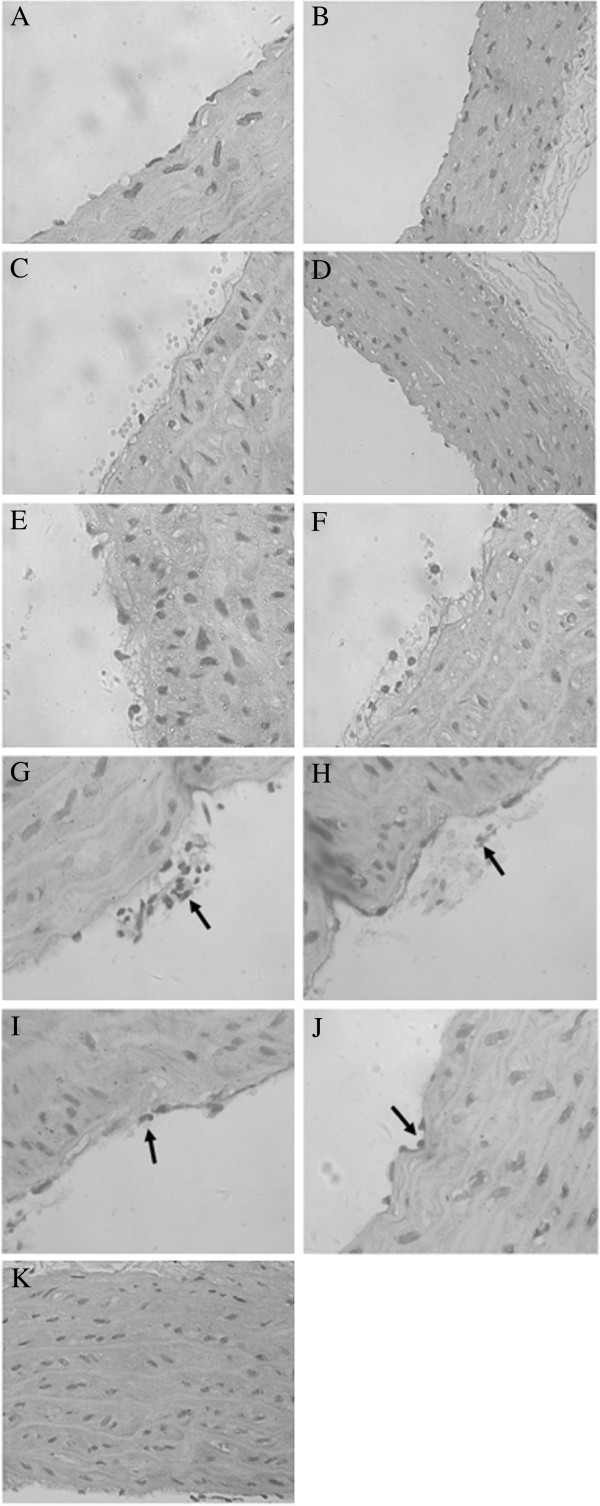
Pathological images of rat arteries from groups A, B, and C. (A) Endothelial cells arranged in order under the vascular intima of group A (×400). (B) There was no obvious proliferation of medial smooth muscle cells in the vascular wall of group A (×200). (C) The morphology of endothelial cells of group B was slightly abnormal (×400). (D) There was no obvious proliferation of medial smooth muscle cells in the vascular wall of group B (×200). (E) Endothelial cells of group C had a foam-like change (×400). (F) Endothelial cells of group C shed from the vessel wall (×400). (G, H) Inflammatory cells accumulated in the vascular intima of group C (×400). (I) Neutrophil granulocytes were seen around the endothelial cells of group C (×400). (J) Mononuclear cells were seen around the endothelial cells of group C (×400). (K) Smooth muscle cells of group C proliferated, thickened, and had no order (×200).